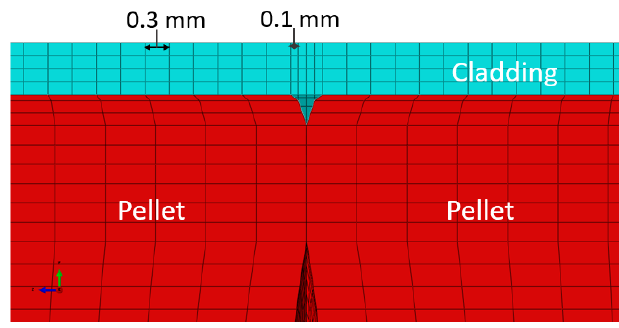
Figure 5. Detailed fuel rod segment model of 56.7 mm.